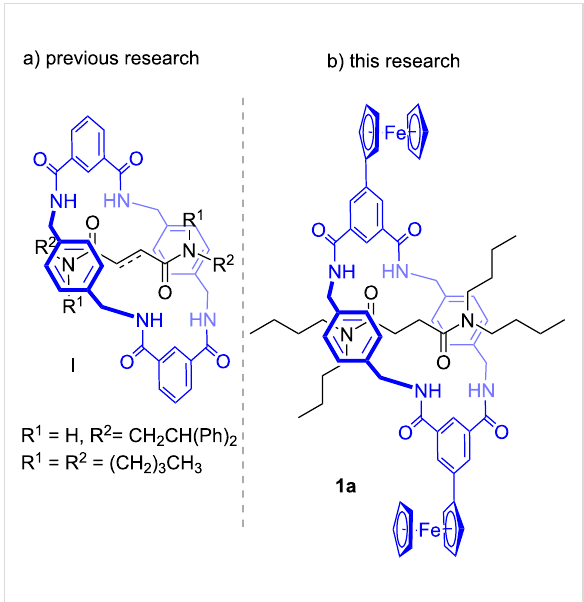
Figure 1: (a) Non-functionalized rotaxanes previously described in the literature. (b) The redox-active rotaxane developed in this work.